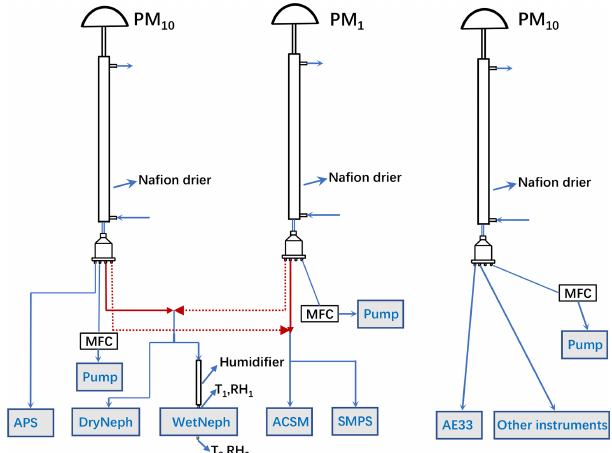
Figure 1. Schematic diagram of the inlet systems for aerosol sam- pling